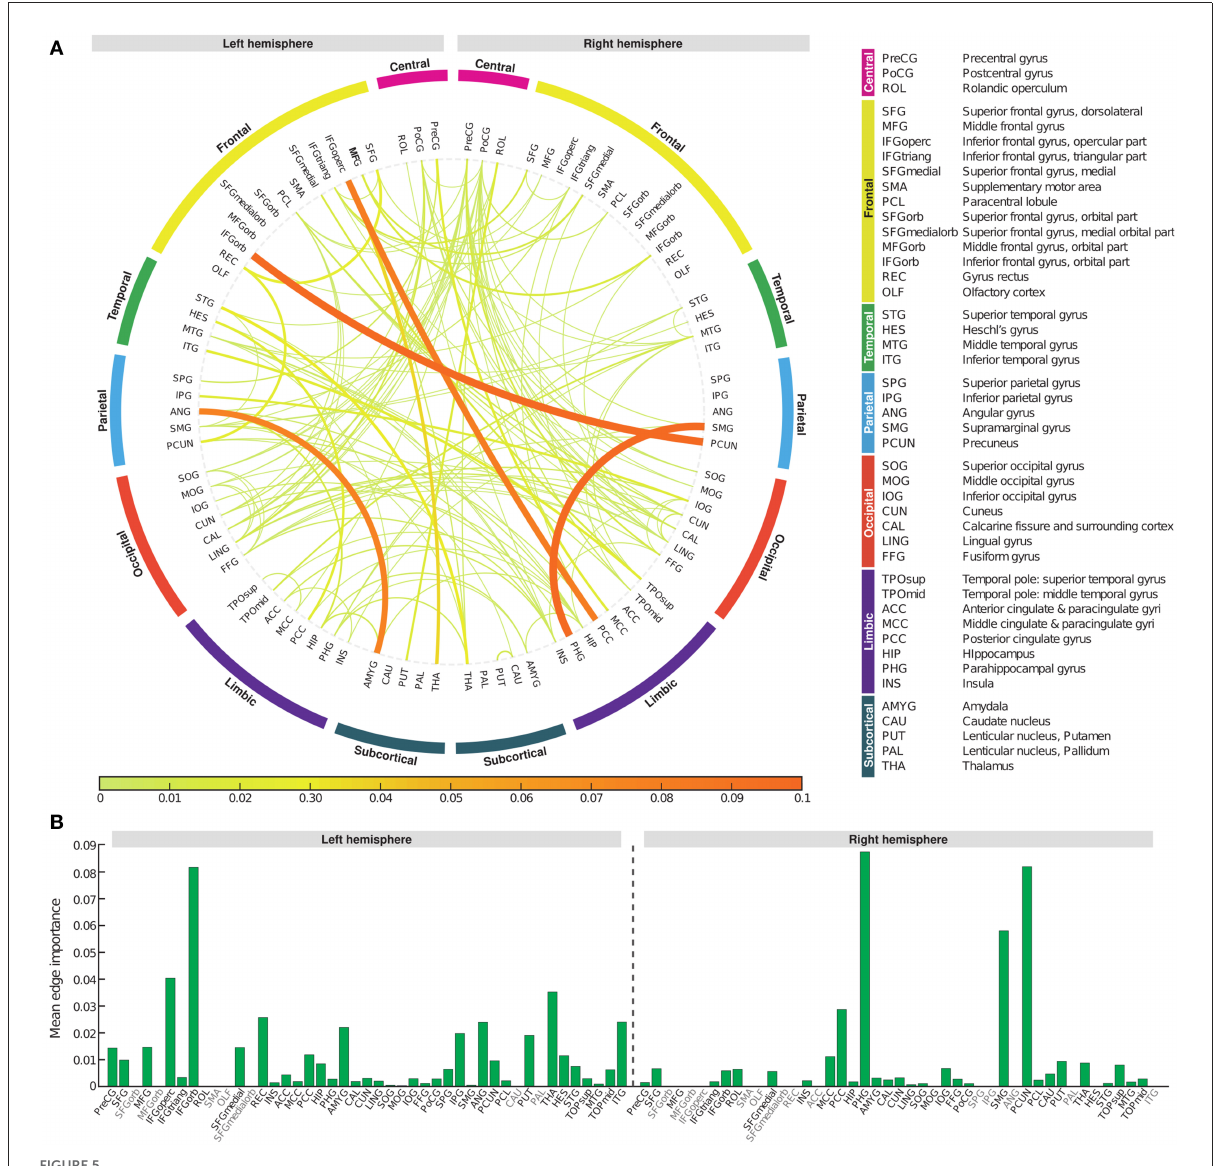
FIGURE5 Edge importance profiles for connectivity-based biomarkers associated with Alzheimer’s disease progression represented by the five stages. (A) A connectogram in which line thickness and color indicate the corresponding edge importance value. (B) The average value of edge importance for each brain region’s incident